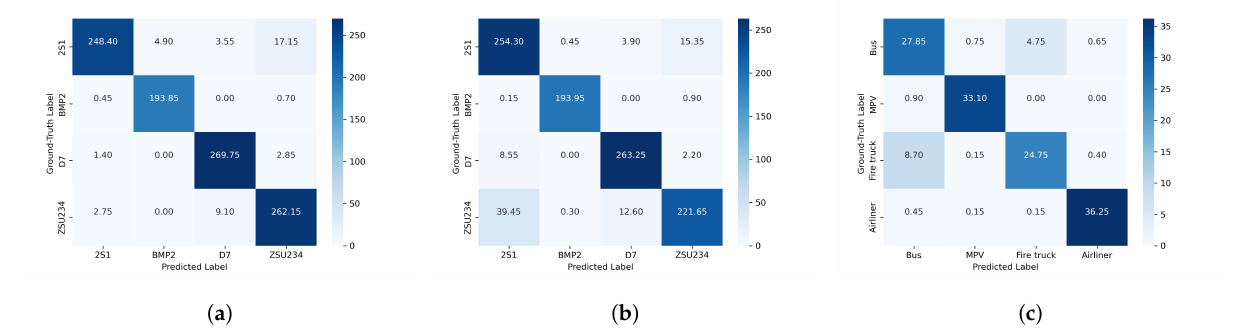
Figure 7. The average confusion matrix of our proposed method: ( a ) MSTAR “4-way 5-shot” condi- tion, ( b ) MSTAR “4-way 1-shot” condition, ( c ) VA “4-way 1-shot”